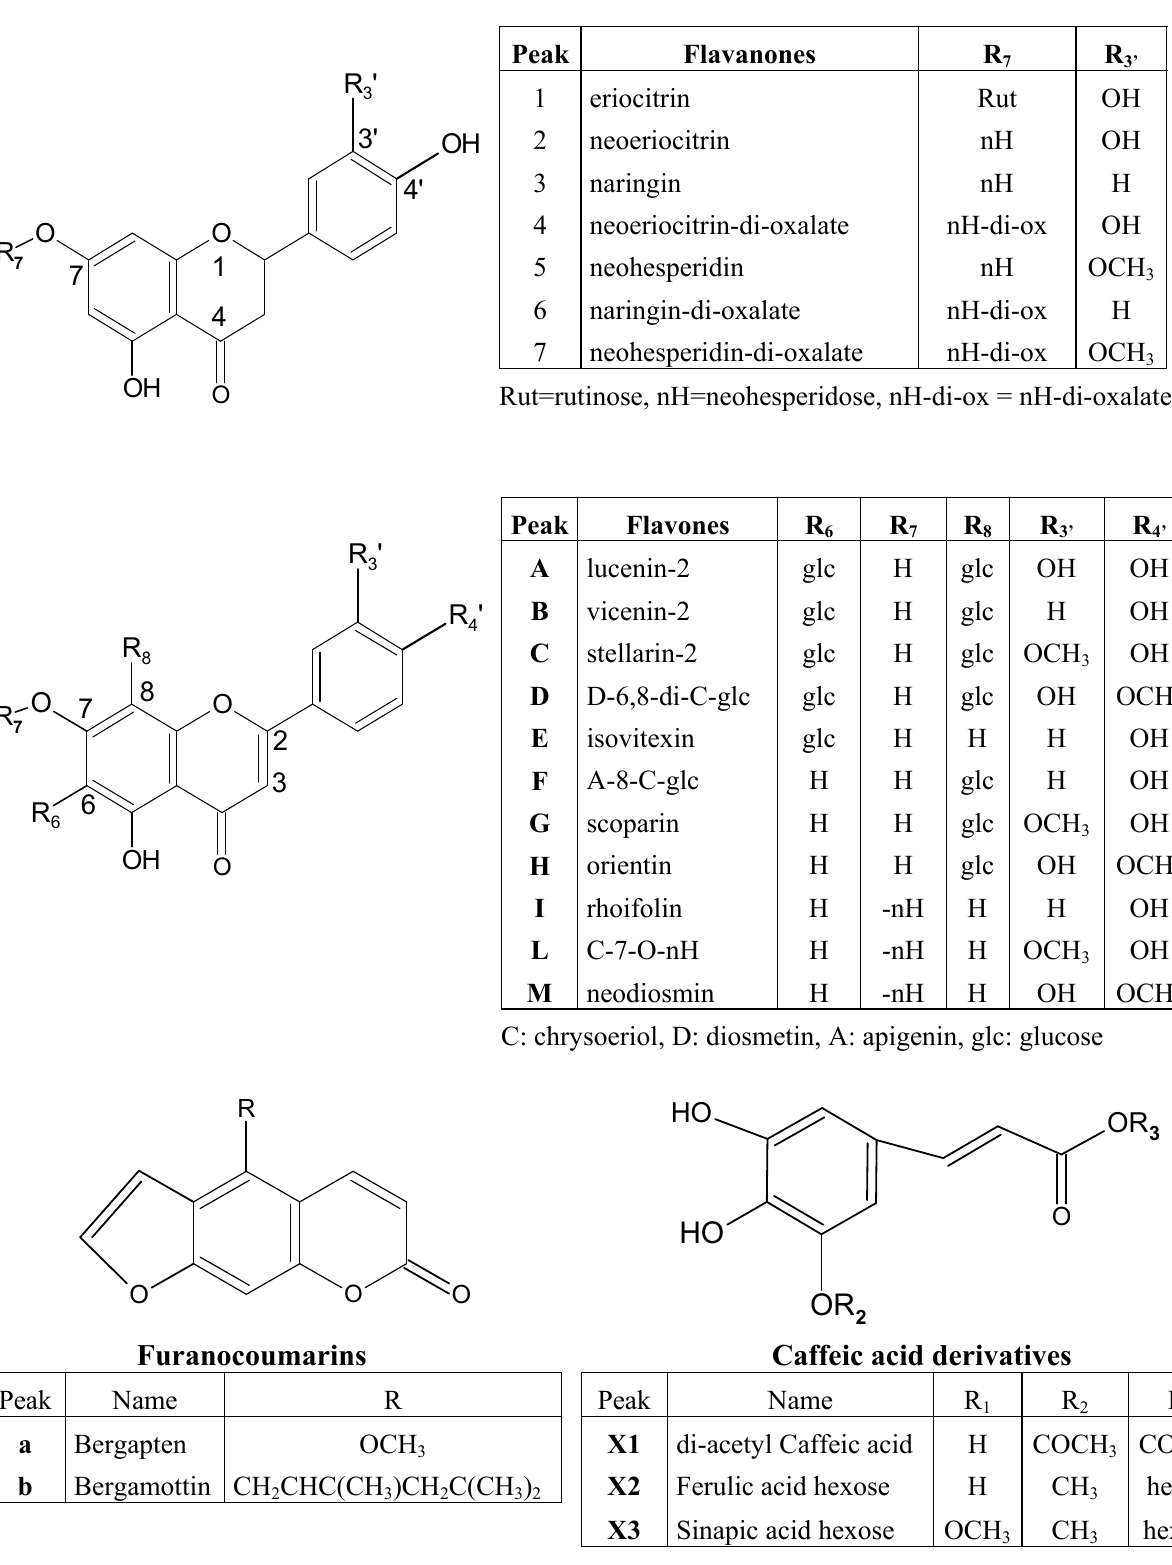
Figure 1. Structures of flavonoids, cinnamic acid derivatives and furanocoumarins founds in